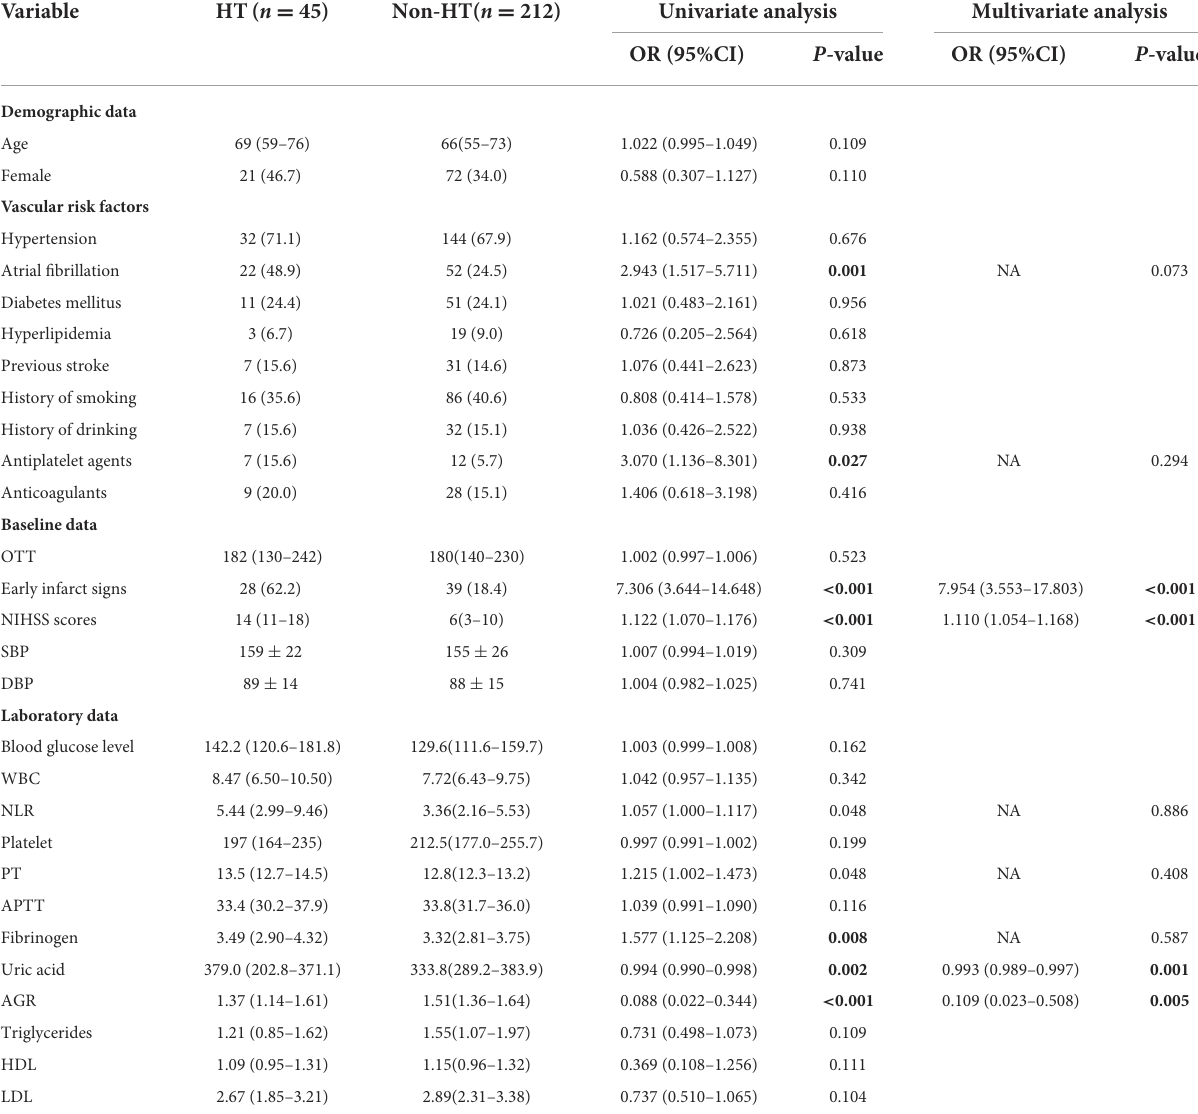
TABLE 2 Baseline characteristics and logistic regression analysis between the HT group and non-HT group in the training cohort.